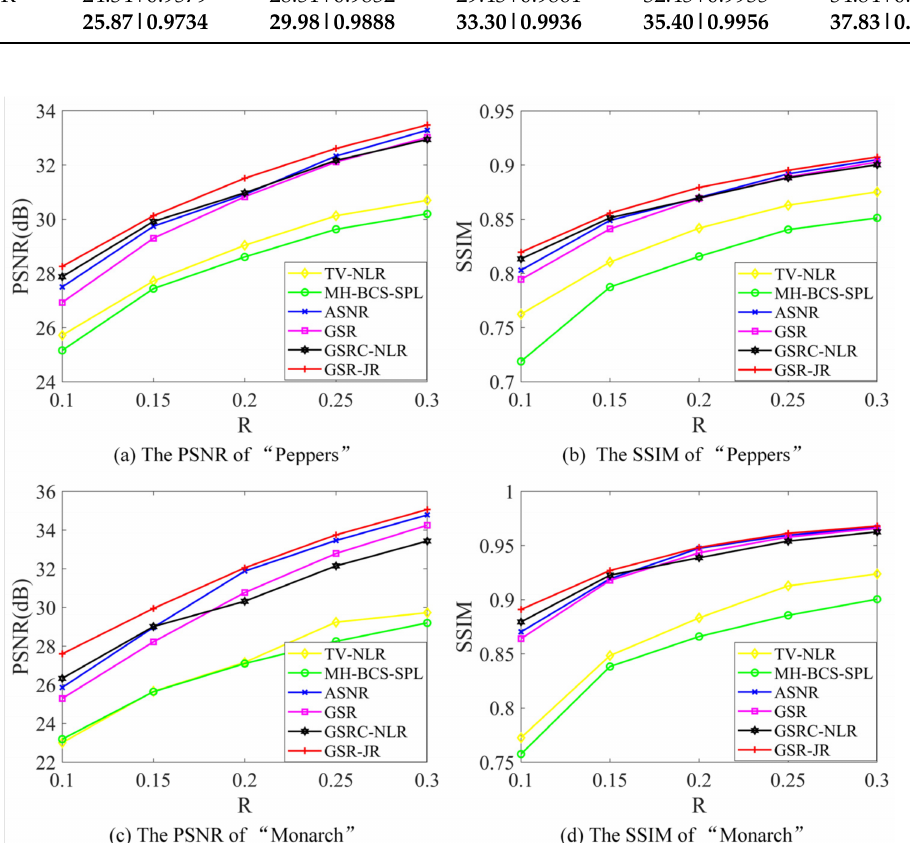
Figure 7. The PSNR and SSIM of different images at all sensing rates. ( a ) The PSNR of “Peppers”, ( b ) the SSIM of “Peppers”, ( c ) the PSNR of “Monarch”, and ( d ) the SSIM of